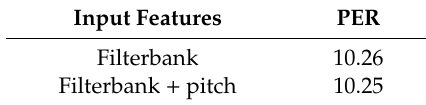
Table 14. Performance Comparison of ASR systems before and after adding pitch features.